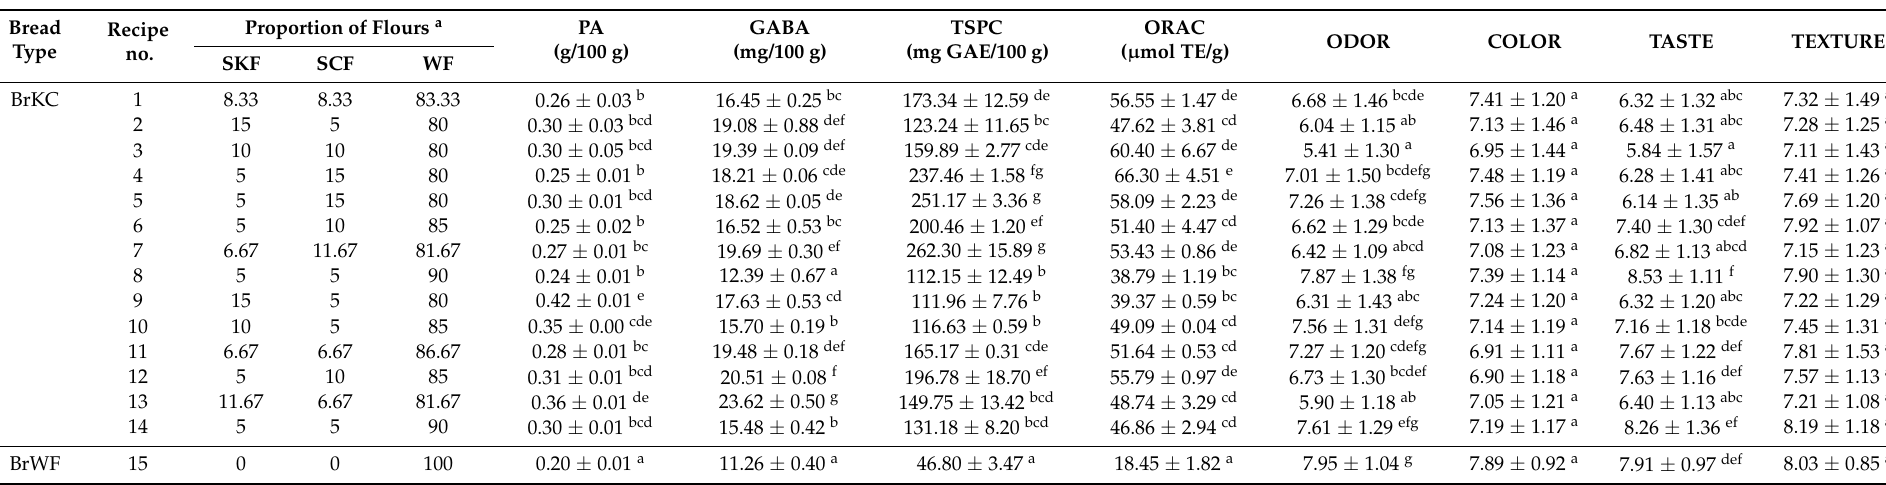
Table 2. Effect of flour formulation with ternary blends of WF, SKF and SCF on nutritional and sensory parameters of bread. Bread Recipe Type